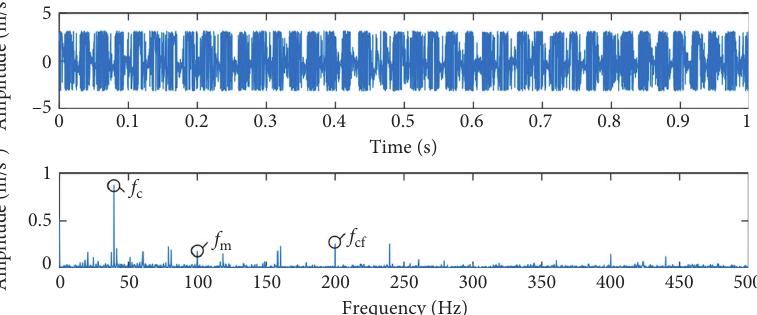
Figure 14: Signal processed by